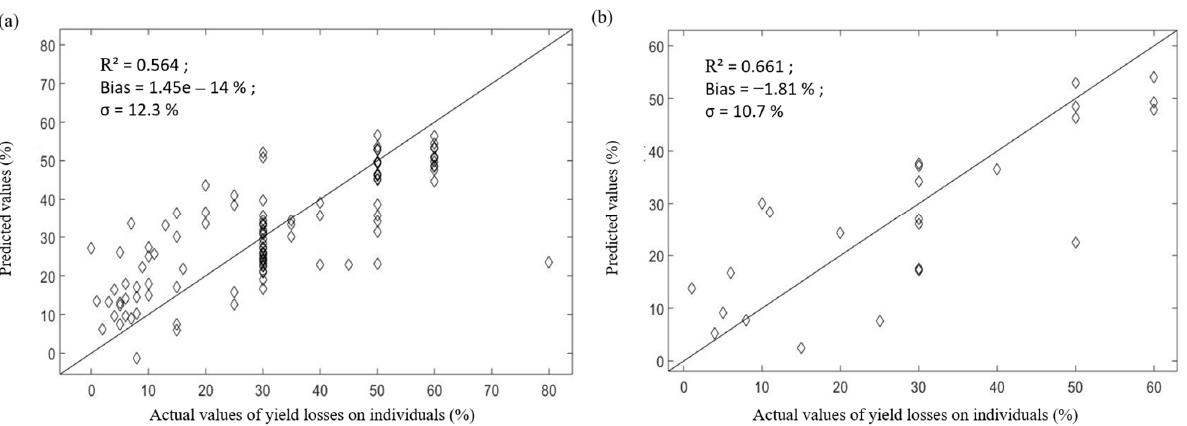
Figure 8. Results of the N-PLS prediction yield losses on individuals in the calibration set ( a ), with 80 vineyard blocks and in the validation test ( b ), with 27 vineyard blocks [18].